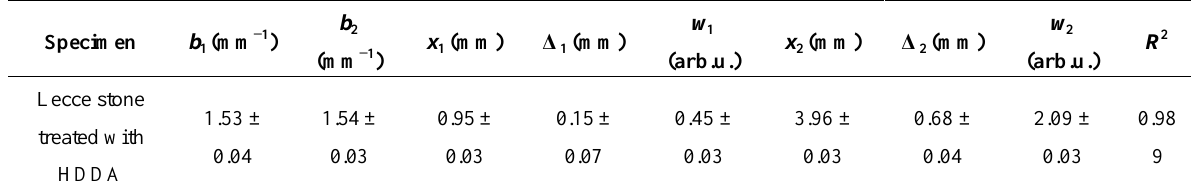
Table 1. Parameters obtained by fitting the profile of treated Lecce stone to Equations (3) and